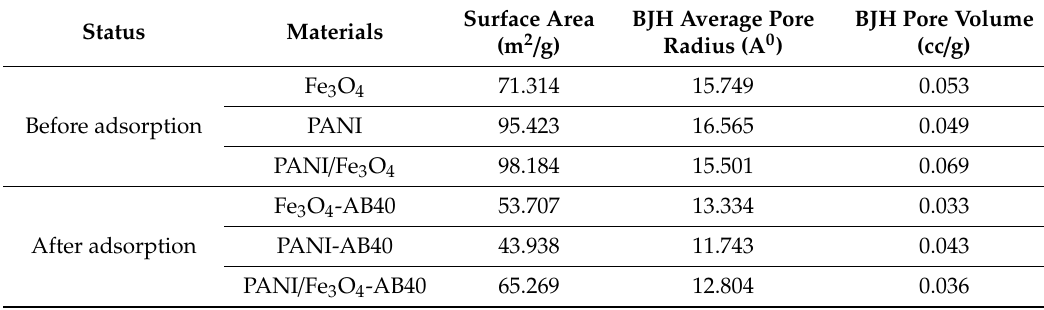
Figure 5. Brunauer–Emmett–Teller (BET) surface area of Fe 3 O 4 , PANI and PANI / Fe 3 O 4 composites before ( A ) and after ( B ) the adsorption of AB40. Table 1. Surface area, average pore volume and pore radius of PANI, Fe 3 O 4 and PANI / Fe 3 O 4